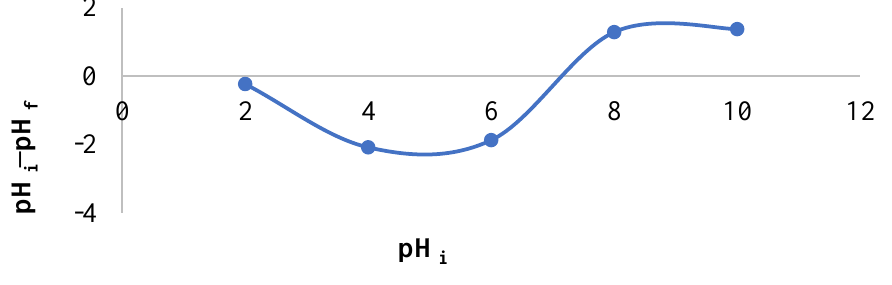
Figure 3. Zn/Cu-FVSP pH ZPC.